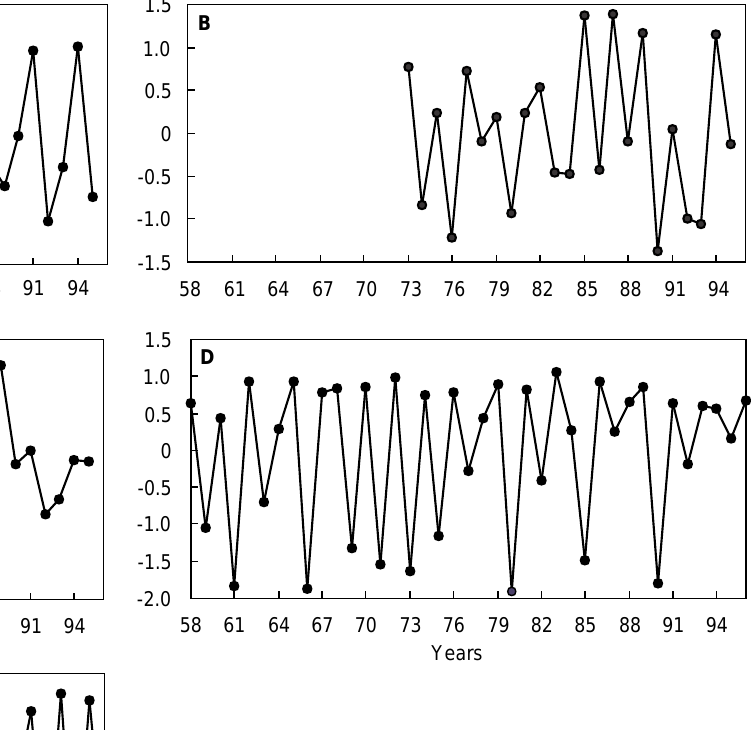
Fig. 1a–e. Time series of the a January b February and c March means of total ozone (in Dobson units) over Northeastern Europe between 1973–1995, and the January–February mean equatorial zonal wind at d 50 hPa and e 30 hPa for 1958–1996. All time series have been normalized (the long-term mean subtracted and then divided by the standard deviation). The negative linear trends from ozone time-series have